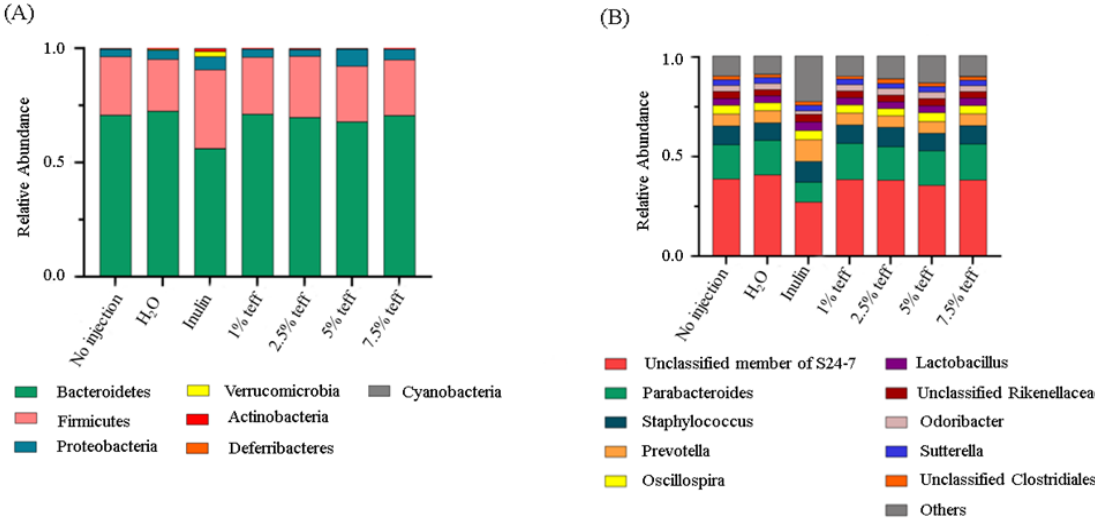
Figure 5. Compositional changes of the gut microbiota. ( A ) Phylum-level differences between the intra-amniotic administration measured at day of hatch (day 21); ( B ) Genus-level differences between the intra-amniotic administration groups as measure at day of hatch (day 21).